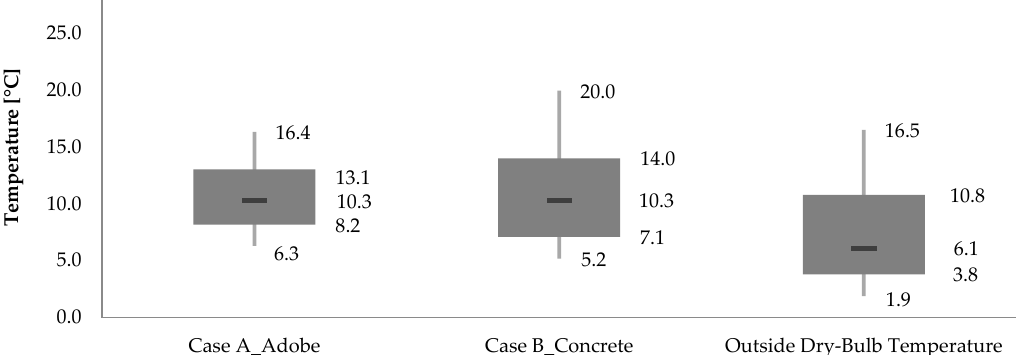
Figure 3. Observed temperature maximum, minimum, and interquartile range distribution.